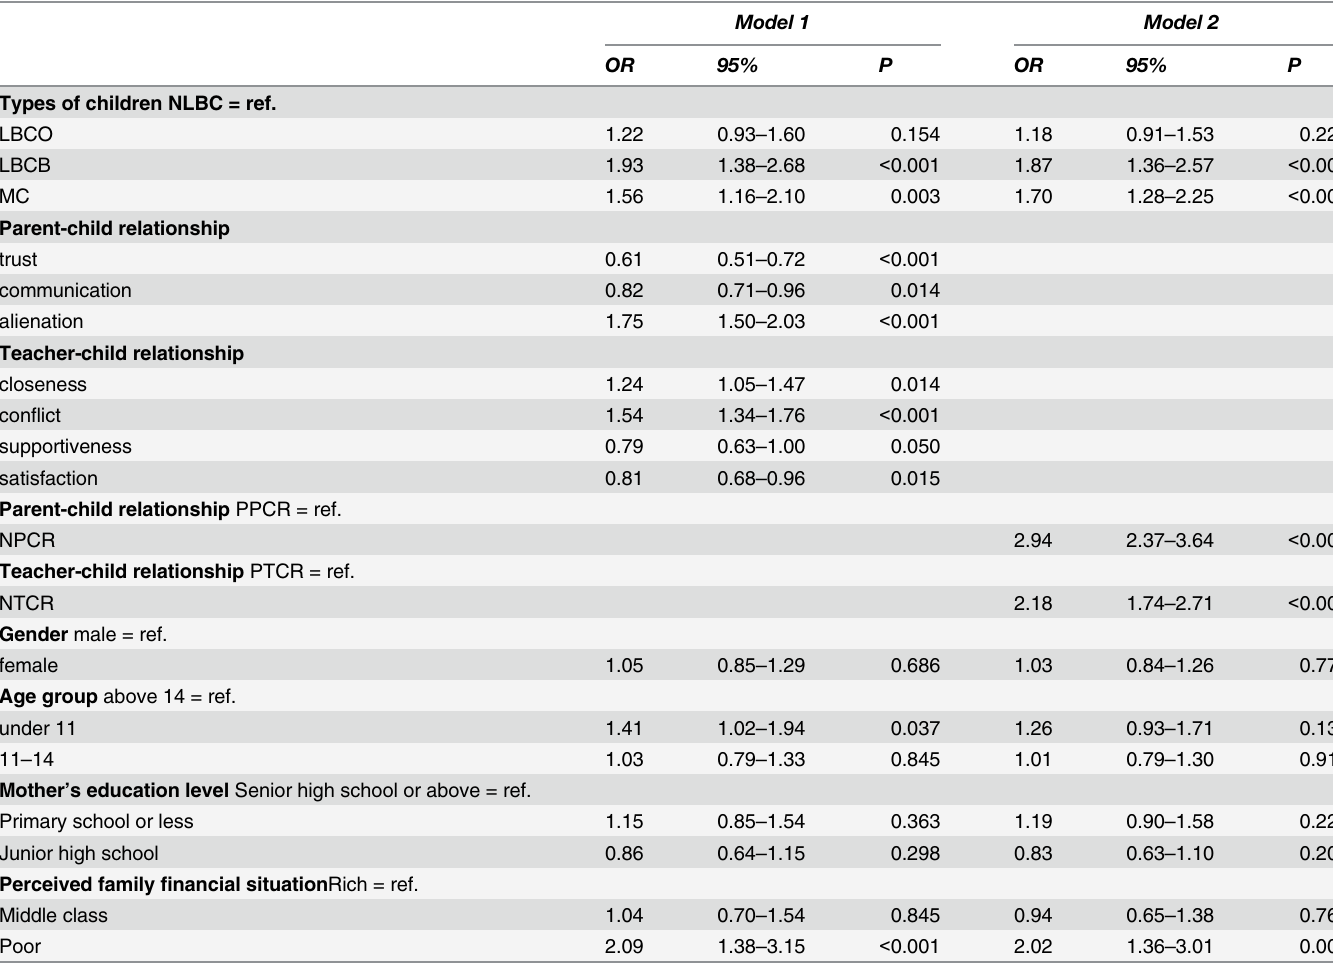
Table 4. Regression analysis for depression by type of child, interpersonal relationship quality ratings, subscale scores, and demographic char- acteristics (N =